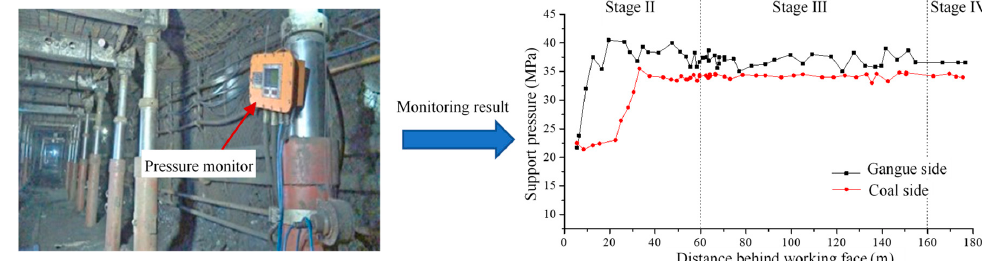
Figure 21. Monitored pressure of the gate type hydraulic support in the retained entry.